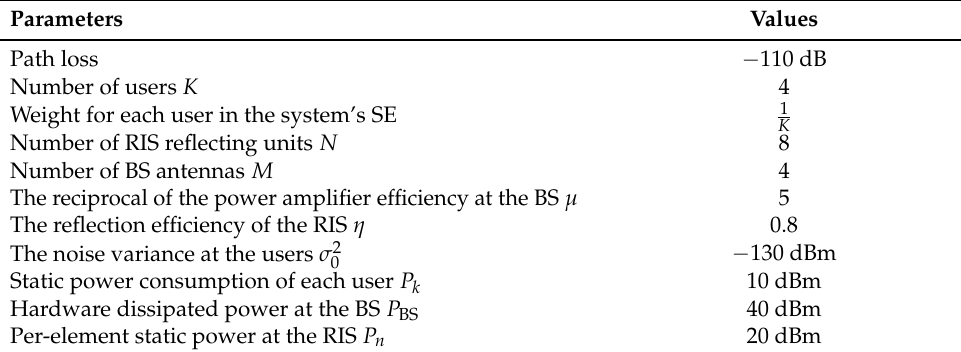
Table 1. Simulation setup parameters.